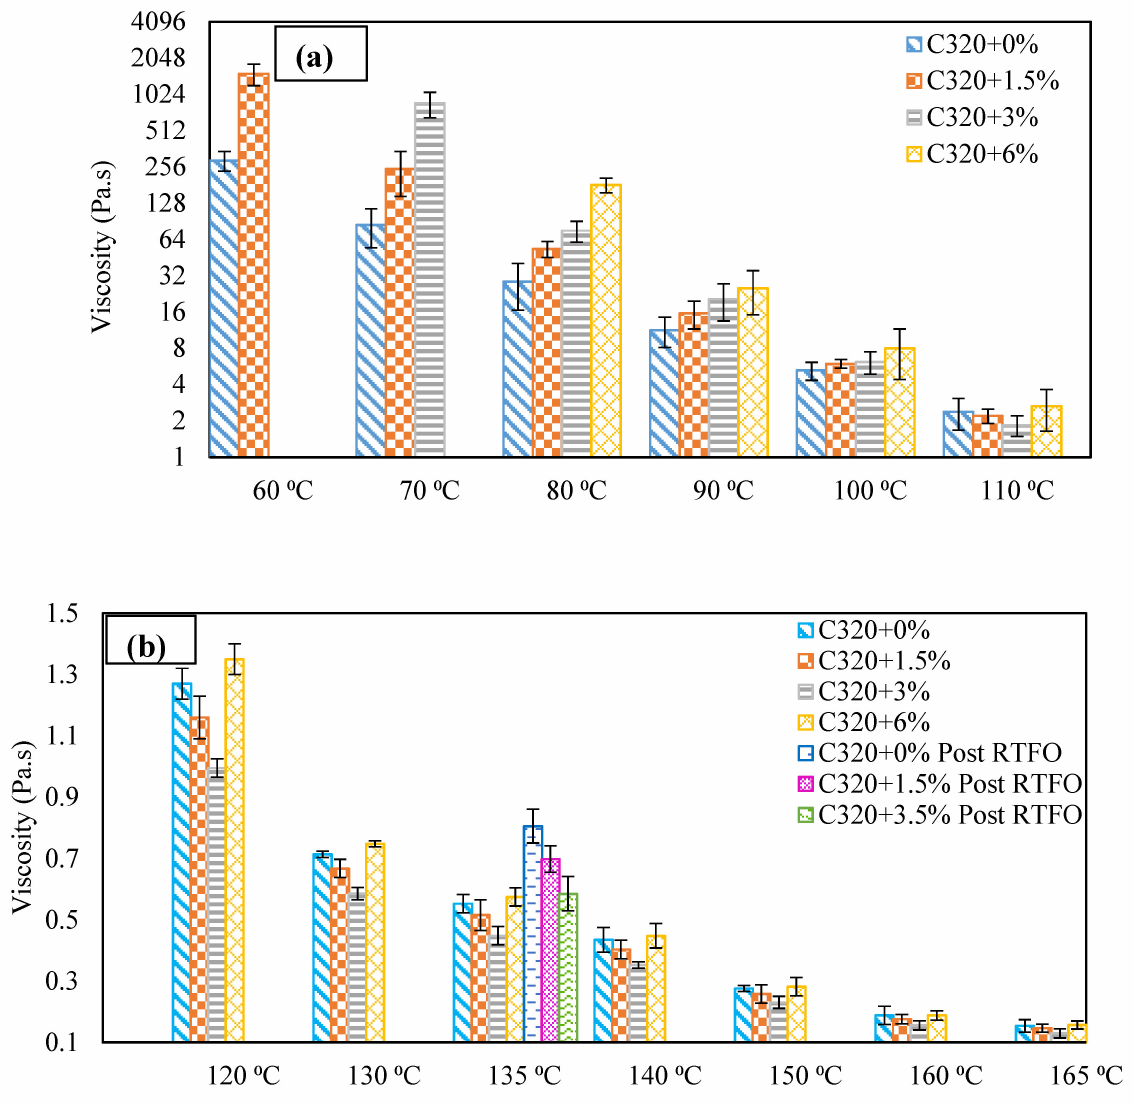
Figure 3. Viscosity results at different temperatures for C320 bitumen mixed with Sasobit: ( a ) viscosity